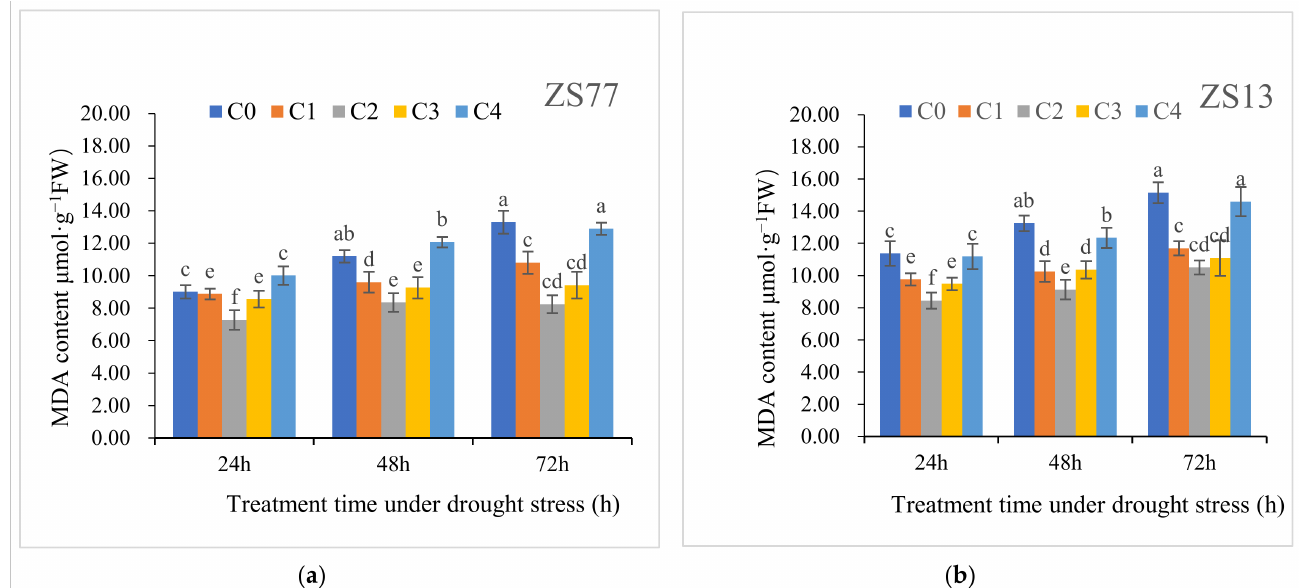
Figure 4. Effect of different concentrations of exogenous SA solution 0 (C0), 1.00 (C1), 2.00 (C2), 4.00 (C3), and 8.00 mg · L − 1 (C4) on MDA content of sweet-potato leaves under drought stress. Bars with different letters indicate significant differences among treatments at 0.05 level